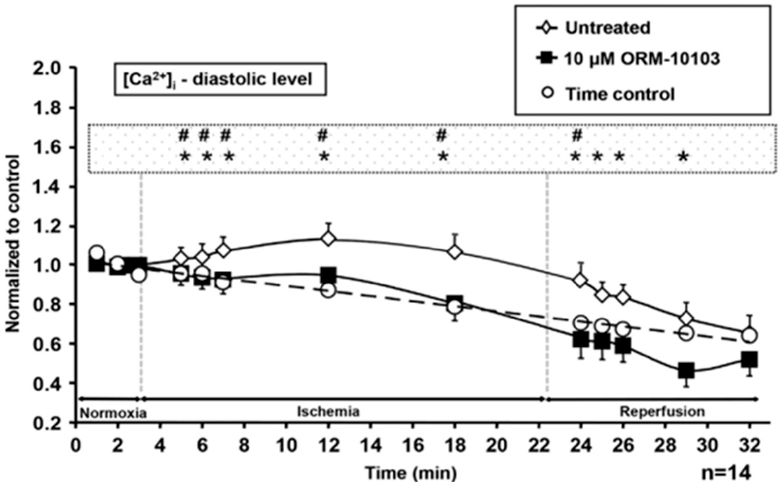
Figure 5. Selective NCX inhibition by 10 µM ORM-10103 avoids diastolic Ca 2+ increase during simulated cellular ischemia in canine isolated ventricular myocytes. # and * indicate significant ( p < 0.05) difference between time control vs. untreated and untreated vs. ORM-treated values, respectively. Reprinted with permission from Ref. [81]. 2022, Elsevier.